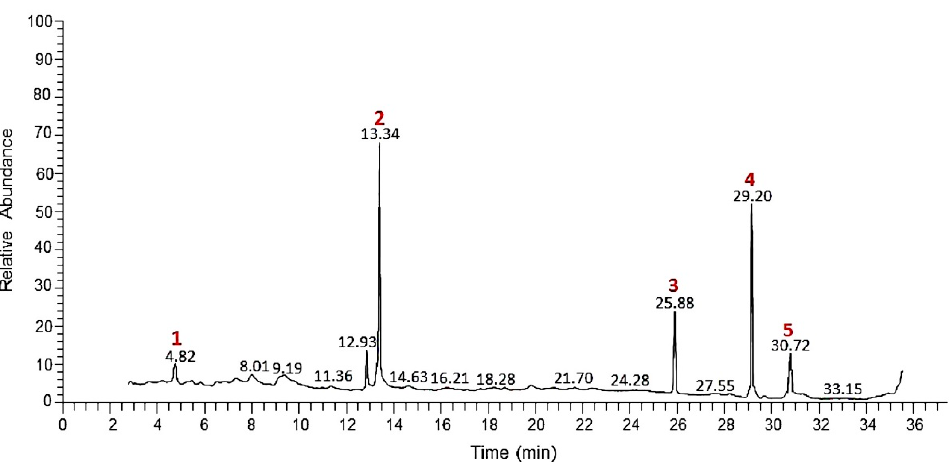
Figure 2. Chromatogram of basic chemical components interpreted from the MeOH extract of M. longipetala aboveground parts by GC-MS. The major compounds peaks are numbered in red color from 1-5. Table 1. Chemical characterization of the identified components in the aboveground parts of M. longipetala using GC-MS analysis.